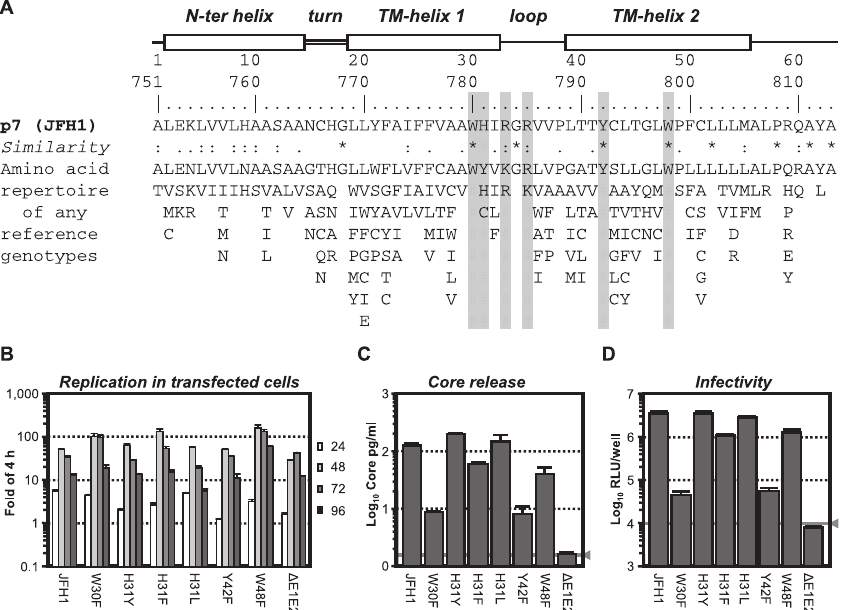
Figure 2. Identification of Conserved Amino Acids Essential for p7 Functioning (A) Amino acid repertoire of the 26 representative p7 sequences of confirmed HCV genotypes/subtypes (listed with accession numbers in Table 1 in [1]). Helical turn and loop regions deduced from the nuclear magnetic resonance structure analysis of a p7 GT 1b variant (F. Penin, unpublished data) are depicted at the top, and the primary sequence of JFH1-derived p7 (GT 2a) in combination with a ruler indicating amino acid numbers with respect to p7 and the complete JFH1 genome are given below. The degree of conservation can be inferred by the extent of variability (with the observed amino acids listed in decreasing order of frequency from top to bottom) and the similarity index according to ClustalW convention (asterisk, invariant; colon, highly similar; dot, similar) [46]. Residues mutated in this study are shaded in gray. (B) Replication of Luc-JFH1 and given mutants in transfected Huh7-Lunet cells determined as described above. (C) Release of core protein and (D) infectivity into the culture fluid 72 h post-transfection of cell given in (B). The gray lines indicate the cut-off of the ELISA and the background luciferase activity measured in mock-infected cells, respectively. A representative experiment of at least four independent repetitions is